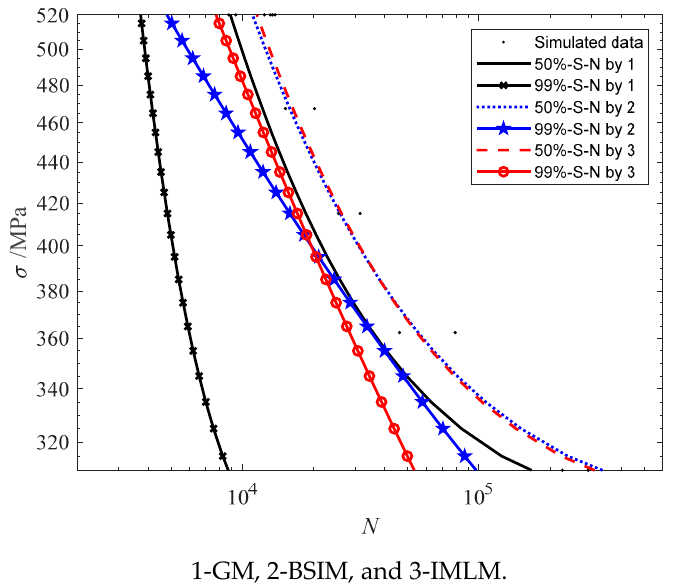
Figure 7. The fitting results of the fatigue test by GM, BSIM, and IMLM.